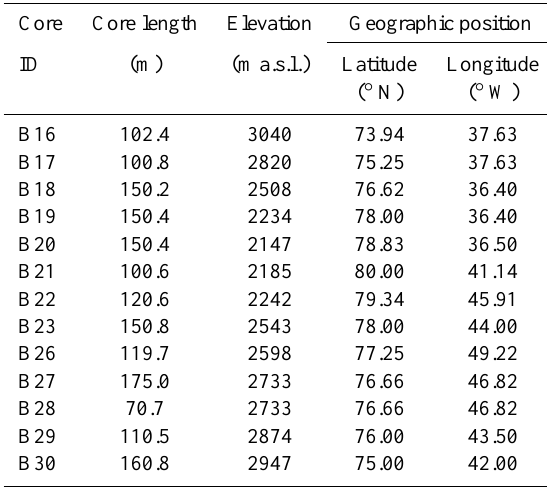
Table 1. Overview of all NGT drill sites. Core